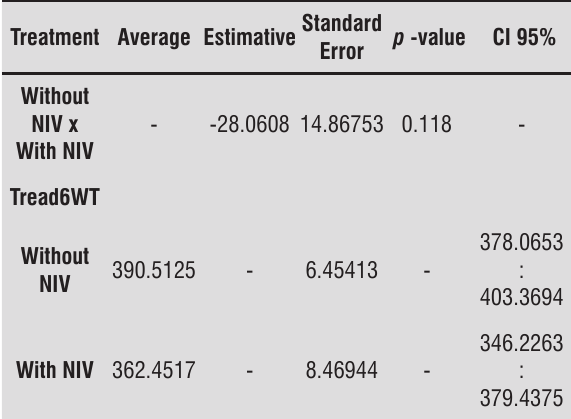
Table 3 - Distance traveled in tread6WT and comparative analysis of both